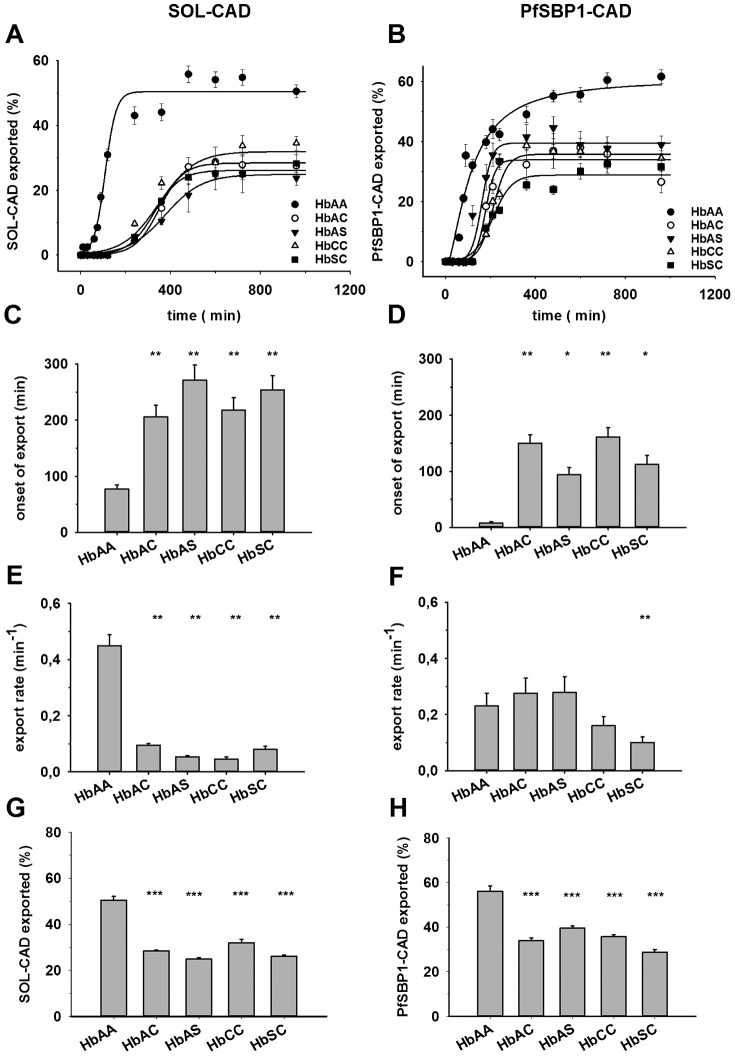
Quantification and export kinetics of SOLCAD and PfSBP1CAD in various parasitized erythrocytes.(A,B) Time courses of conditional SOLCAD or PfSBP1CAD export following the addition of the anti-aggregation ligand. The figure shows the relative amount of SOLCAD (A) and PfSBP1CAD (B), normalized to total cellular fluorescence, exported from the parasite over a period of 960 min following induction, as quantified by fluorescence intensity from microscopic images (see Figs 3 and 4). A logistic curve was fitted to each data set. (C,D) The onset of export was calculated from the fitted curves using the second derivative maximum method (Luu-The et al., 2005) and plotted for each erythrocyte variant. Statistical significance was tested using one-way ANOVA followed by a pairwise t-test with Bonferroni adjustment. *p<0.05; **p<0.01. (E,F) The rate constant of export was determined by fitting a straight line to the linear part of the sigmoid curves of panels A and B. The error bars represent the standard error of mean of the slope estimate of the regression line. Statistical testing was again carried out by one-way ANOVA followed by a pairwise t-test with Bonferroni adjustment. **p<0.01. (G,H) Plateau values of export were obtained from the initial curve fits and analyzed as a function of the different erythrocytes. Statistical significance was determined by one-way ANOVA followed by a pairwise t-test with Bonferroni adjustment. **p<0.001. Error bars correspond to the standard error of the means.